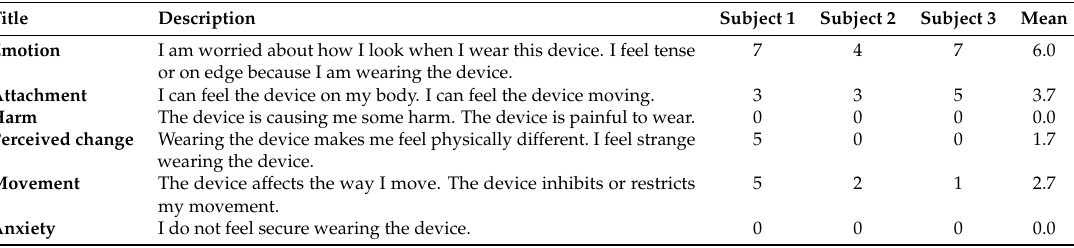
Table 6. Comfort rating scales.